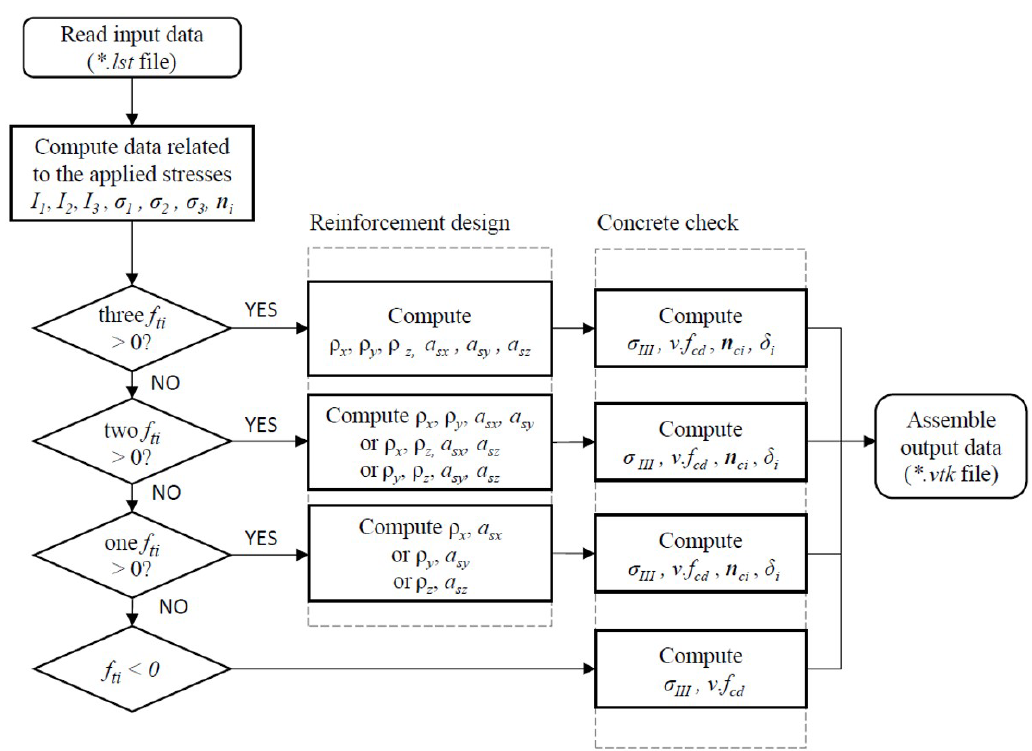
Figure 11. Flowchart of the developed